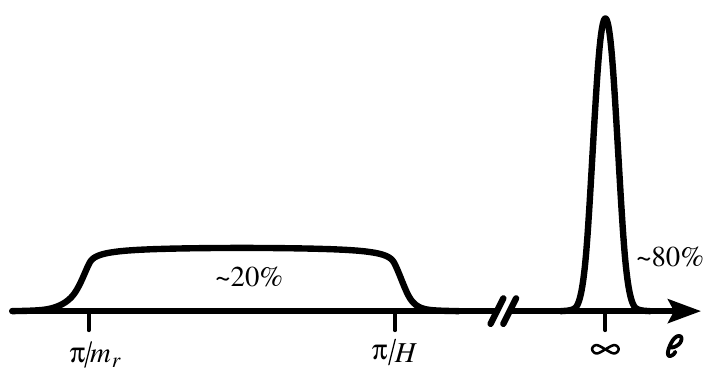
Figure 5 . A cartoon of the distribution of string loops, d(cid:24) ‘ =d‘ , in the scaling regime. A constant fraction of the total length is in sub-Horizon loops, with equal numbers of loops in each logarithmic interval down to the scale of the string